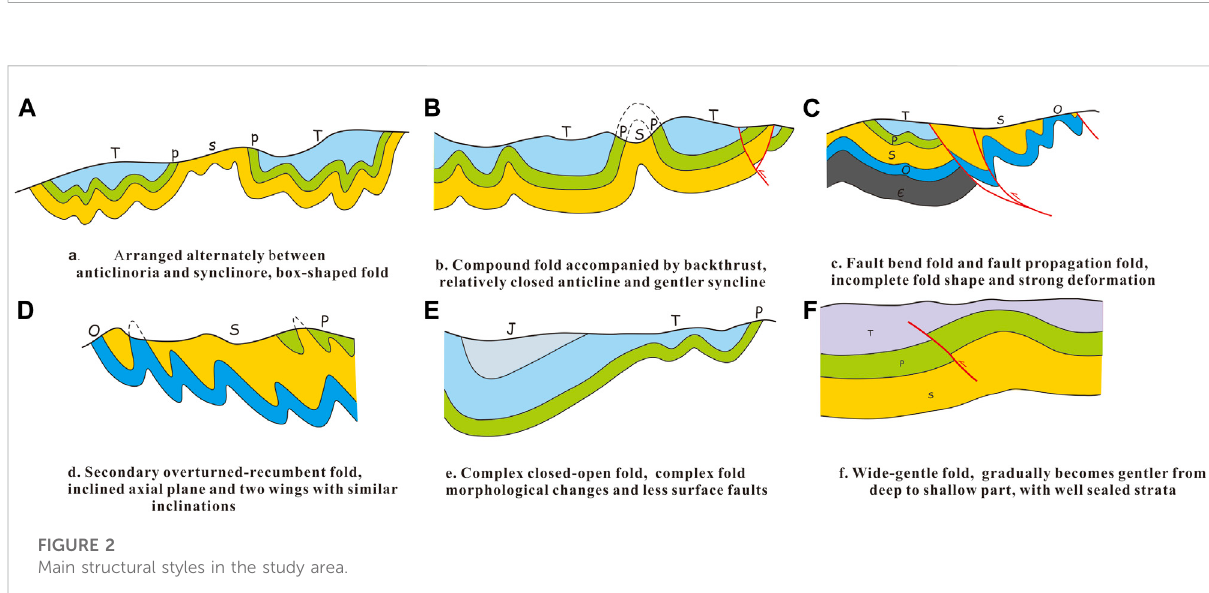
FIGURE 2 Main structural styles in the study